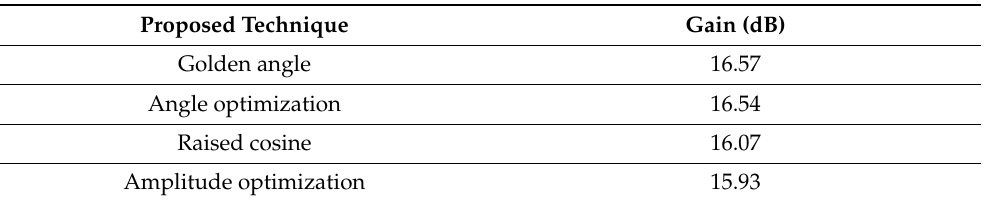
Table 4. Gain values obtained by the electromagnetic simulation for each proposed design case of the Fermat spiral array.